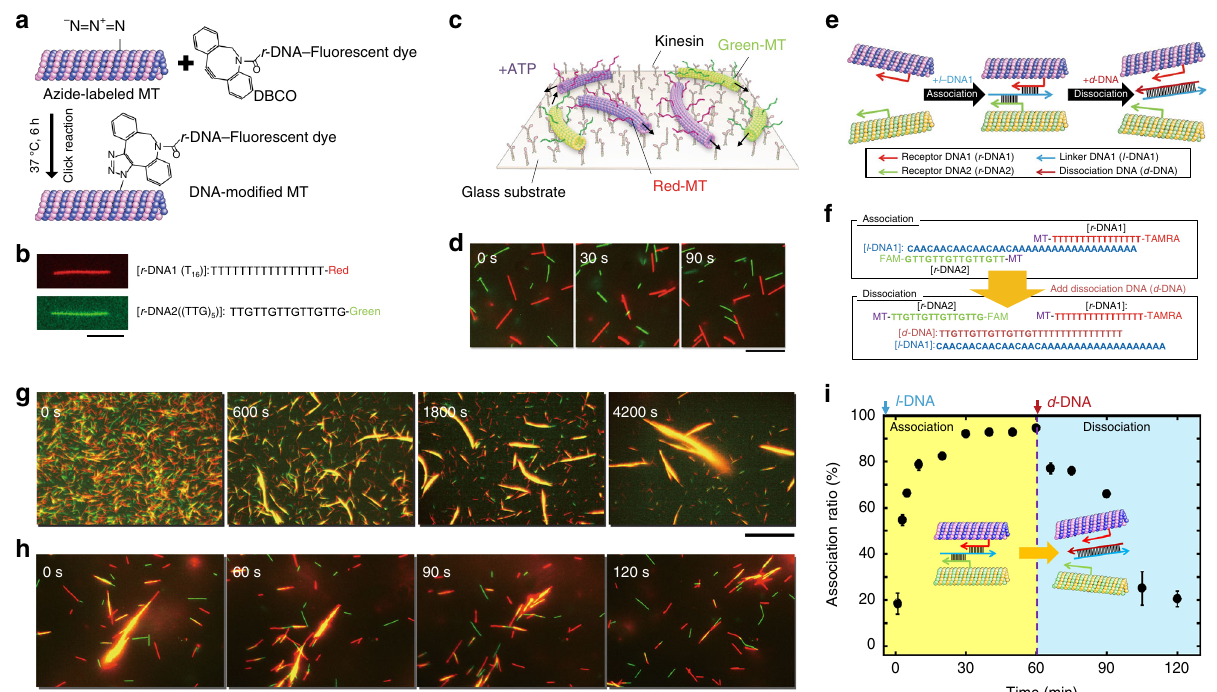
Fig. 1 Preparation of MTs and control of their swarming. a Conjugation of r -DNA to azide-functionalized MTs by a click reaction. b TAMRA (red) and FAM (green) labeled DNA-conjugated MTs with sequences of T 16 ( r -DNA1) and (TTG) 5 ( r -DNA2), respectively. Scale bar: 5 µ m. c Schematic of red and green MTs gliding on kinesins. d Time-lapse images showing motility of rigid MTs with lengths of 5 ± 2 and 5 ± 3 µ m (average ± s.d.) conjugated to T 16 and (TTG) 5 , respectively. Scale bar: 10 µ m. e Schematic of the association of red and green MTs by l -DNA1 and their dissociation by d -DNA via extraction of l -DNA1 through a DNA strand exchange reaction. f Association and dissociation of MTs by DNA base pair interaction. g Time-lapse images showing swarming of MTs. h Dissociation of swarms of MTs. Scale bar: 20 µ m ( g and h ). i Change of association ratio over time after introduction of l -DNA1 (0.6 µ M) and d -DNA (0.6 µ M). The concentration of the red and green MTs was 0.6 µ M each, and the kinesin concentration was 0.3 µ M. Error bar: standard error